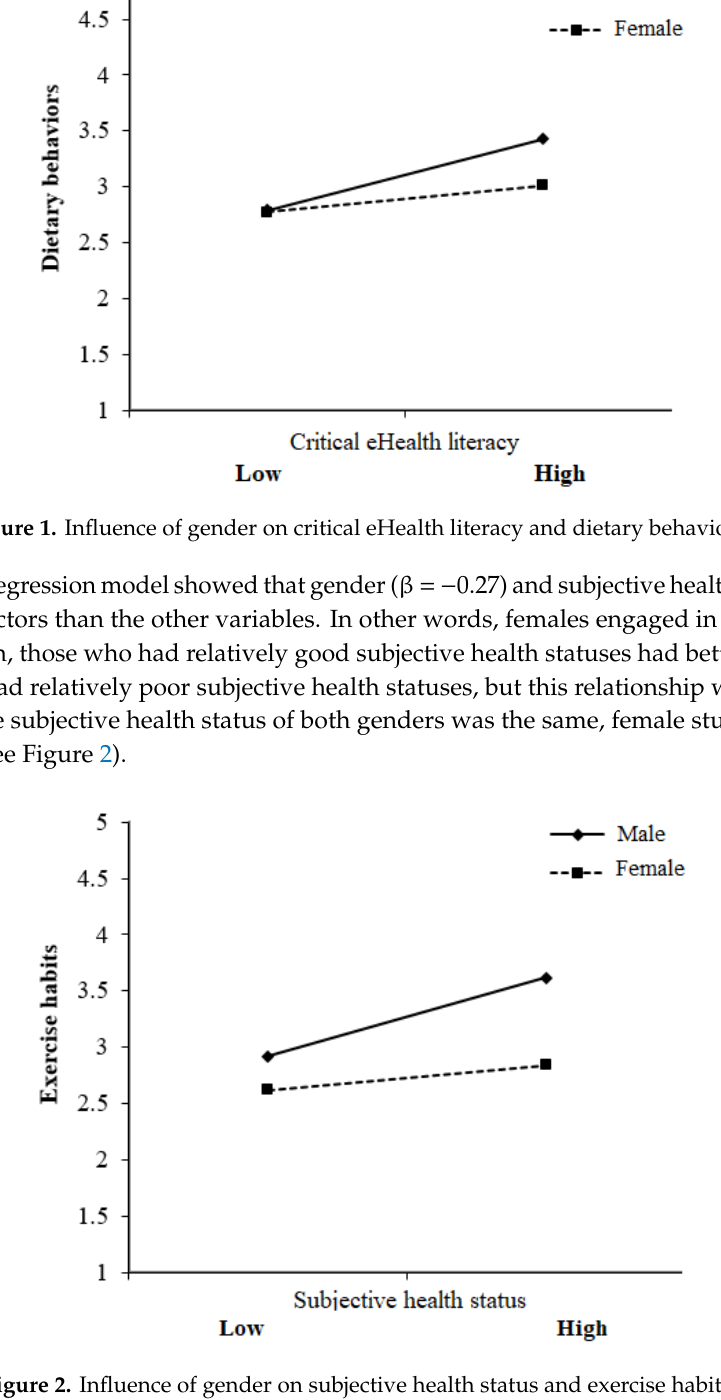
Table 3. Hierarchical regression analysis of exercise habits.